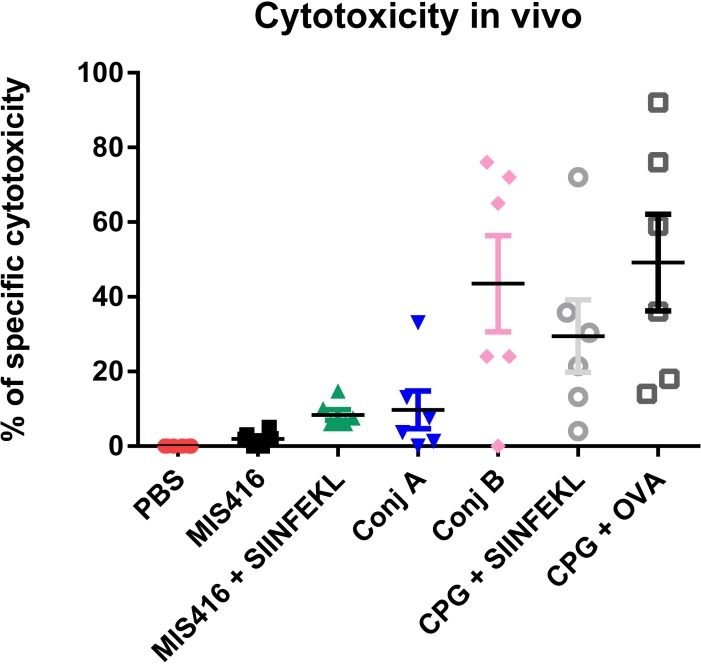
Evaluation of specific cytotoxicity induced by vaccination with MIS416/SIINFEKL conjugates.Six mice were used in each group and they were vaccinated with Conjugation A or B (100 μg), MIS416 (100 μg) plus SIINFEKL (2 μg), MIS416 alone (100 μg), PBS (100 μL), CpG plus SIINFEKL (2 μg) or CpG plus Ovalbumin (10 μL of OVA + 50μg of CpG). After 1 week mice were challenged with two population of splenocytes (1 x 107 cells, pulsed with SIINFEKL or not) and after two days specific cytotoxicity was evaluated. CpG + OVA was used as positive control while PBS and MIS416 were negative controls. Specific cytotoxicity as a percentage was calculated using the ratio between cells stained with VPD450 (pulsed with SIINFEKL) and with CFSE (unpulsed), of the vaccinated groups compared to the control group (PBS).